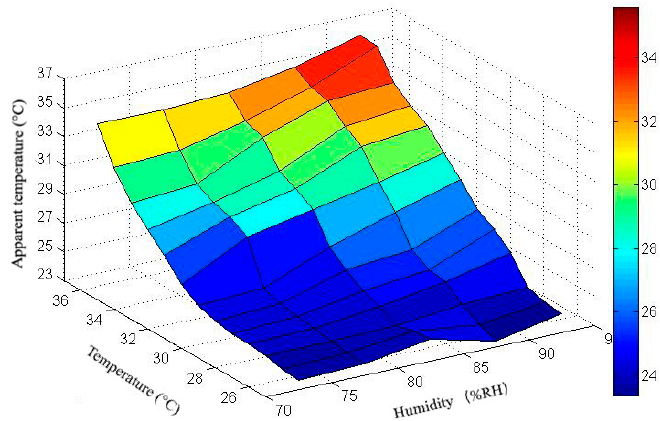
Figure 8. Surface diagram of apparent temperature.